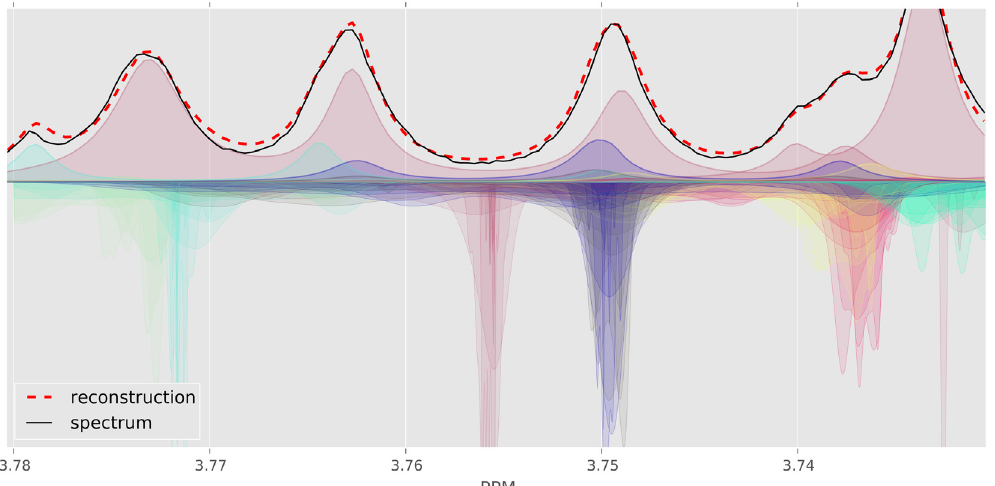
Fig 5. Evolution of Bayesil ’ s distributions for a small region of human serum spectrum. The plots above horizontal axis show the original spectrum (solid black), individual clusters as well as overall fit (dashed red). The curves below horizontal axis show the Bayesil ’ s distribution over chemical shift variables for each cluster ( C ), over 6 iterations of spectral deconvolution. The distributions become more peaked towards the correct center in each iteration. Distributions below the horizon have the color of their associated cluster.